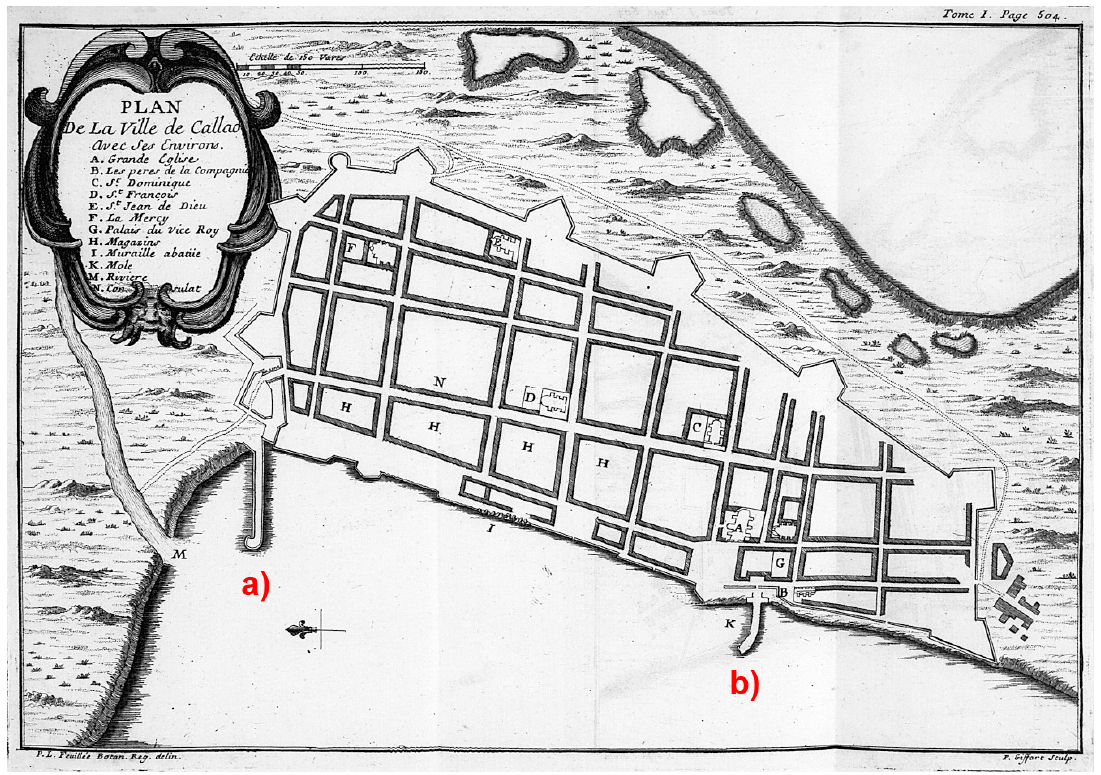
Figure 9 . Callao in a city plan drawn by Feuillée [36], in 1710 (1714 ed). On the eastern side of the town, the jetty designed by de Rosmain and never realized ( a ); on the western side the 1694 jetty ( b ). Courtesy: ETH-Bibliothek Zürich.